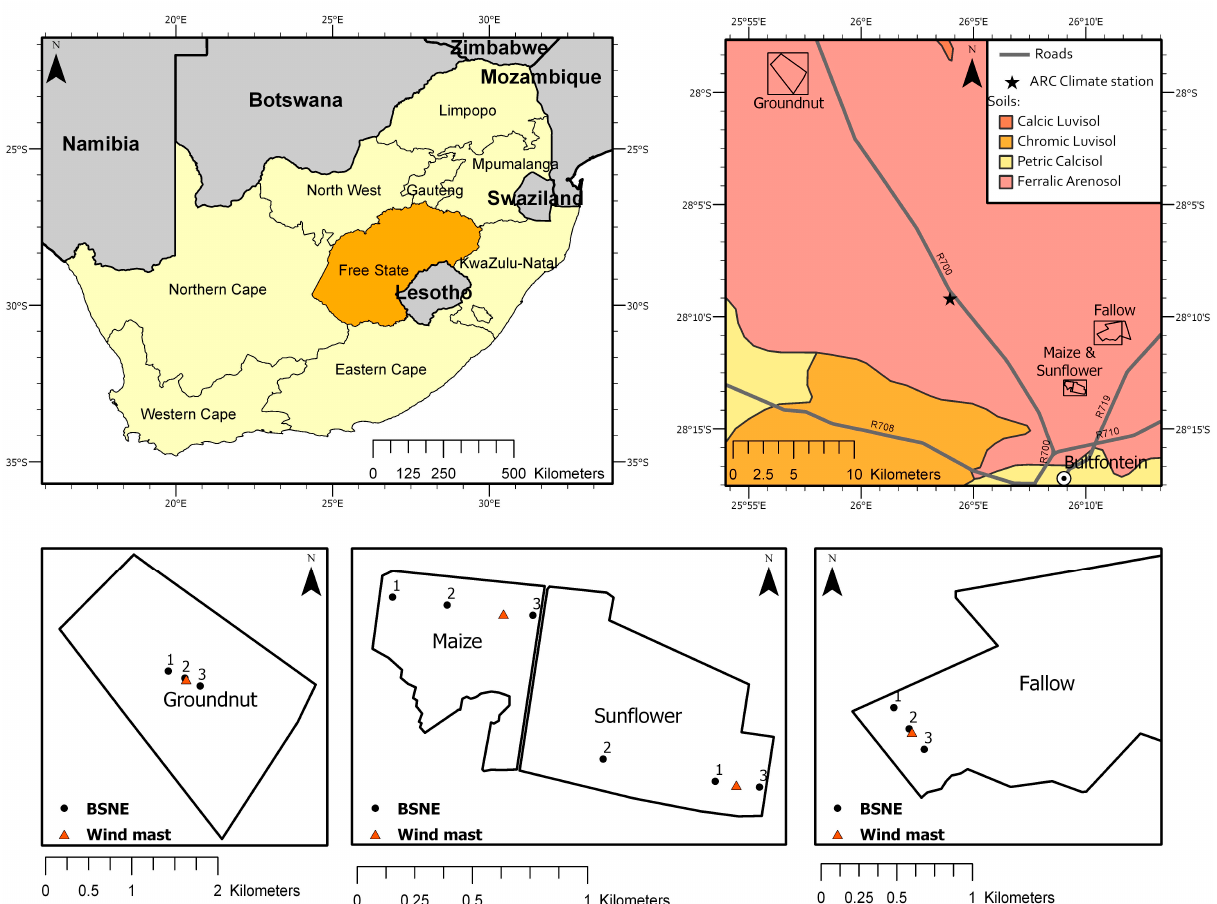
Figure 3. South Africa ( top left ), the soil map of the study area ( top right ), and the fields that were selected for monitoring ( bottom ) with the location of the Big Spring Number Eight (BSNE) and wind masts.